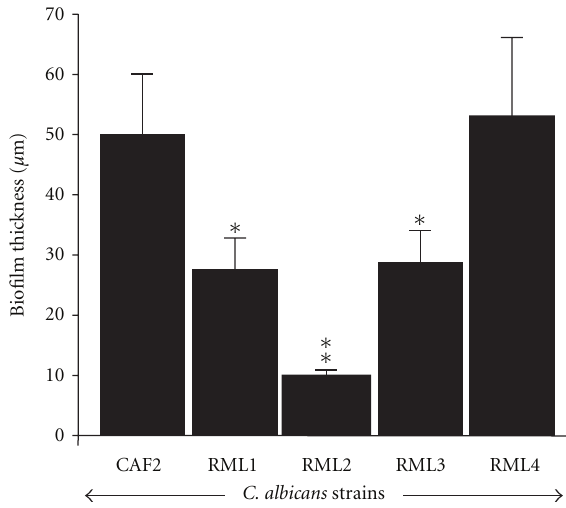
Figure 3: E ff ect of ECM33 gene on the ability of C. albicans to form biofilm on EHOM. Following infection with each Candida strain and culture for 24h, a quantitative assessment of the thickness of the biofilm formed on the EHOM tissues was performed. Means + SD ( n = 4) were plotted. Di ff erences were obtained by comparing the biofilms obtained with the CAF2 strain and the other Candida strains. ∗ P < 0 . 05; ∗∗ P < 0 . 01.